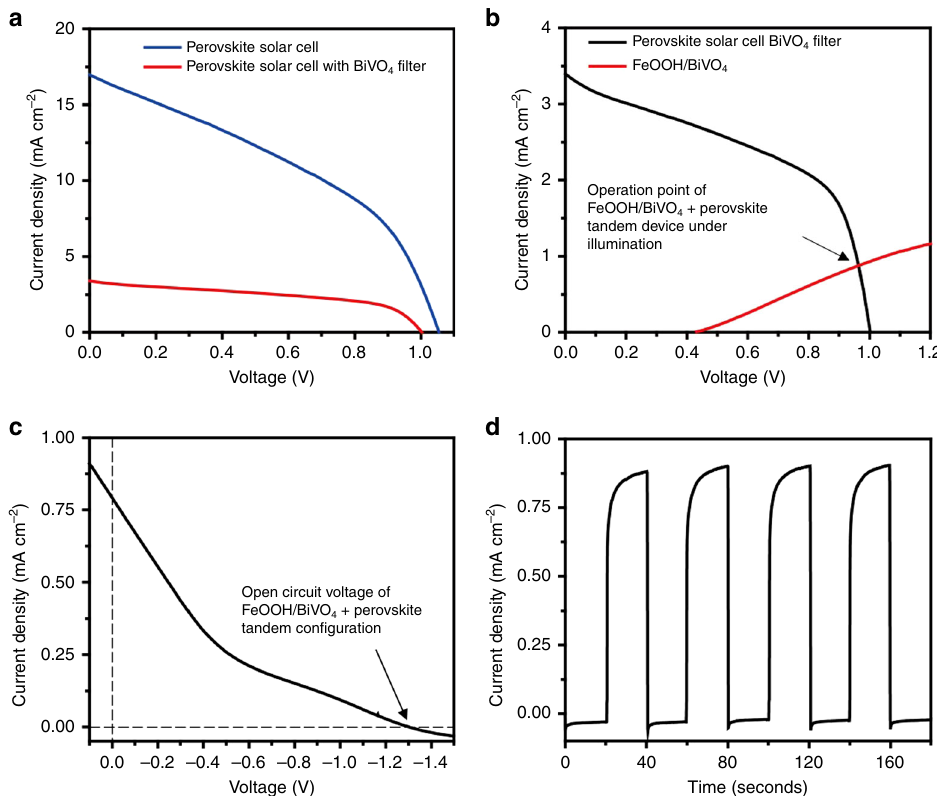
Fig. 3 Performances of the perovskite solar cell and the PEC tandem con fi guration. a I – V characteristics of perovskite solar cell under illumination (AM 1.5 G, 100 mW cm − 2 ) with (red) and without (blue) BiVO 4 fi lter. The active area of solar cell was 1 cm 2 . b Overlap of I – V pro fi les of FeOOH/BiVO 4 photoanode (red) and perovskite solar cell under fi ltered illumination (black). The intersection of two graphs indicates an operation power of the tandem device. c Linear sweep voltammetry of the tandem device in a two-electrode con fi guration (i.e., FeOOH/BIVO 4 /perovskite and Pt wire). The voltage at zero current density designates the open-circuit voltage of the tandem system under illumination. d Photocurrent density pro fi le of FeOOH/BiVO 4 /perovskite solar cell with a two-electrode con fi